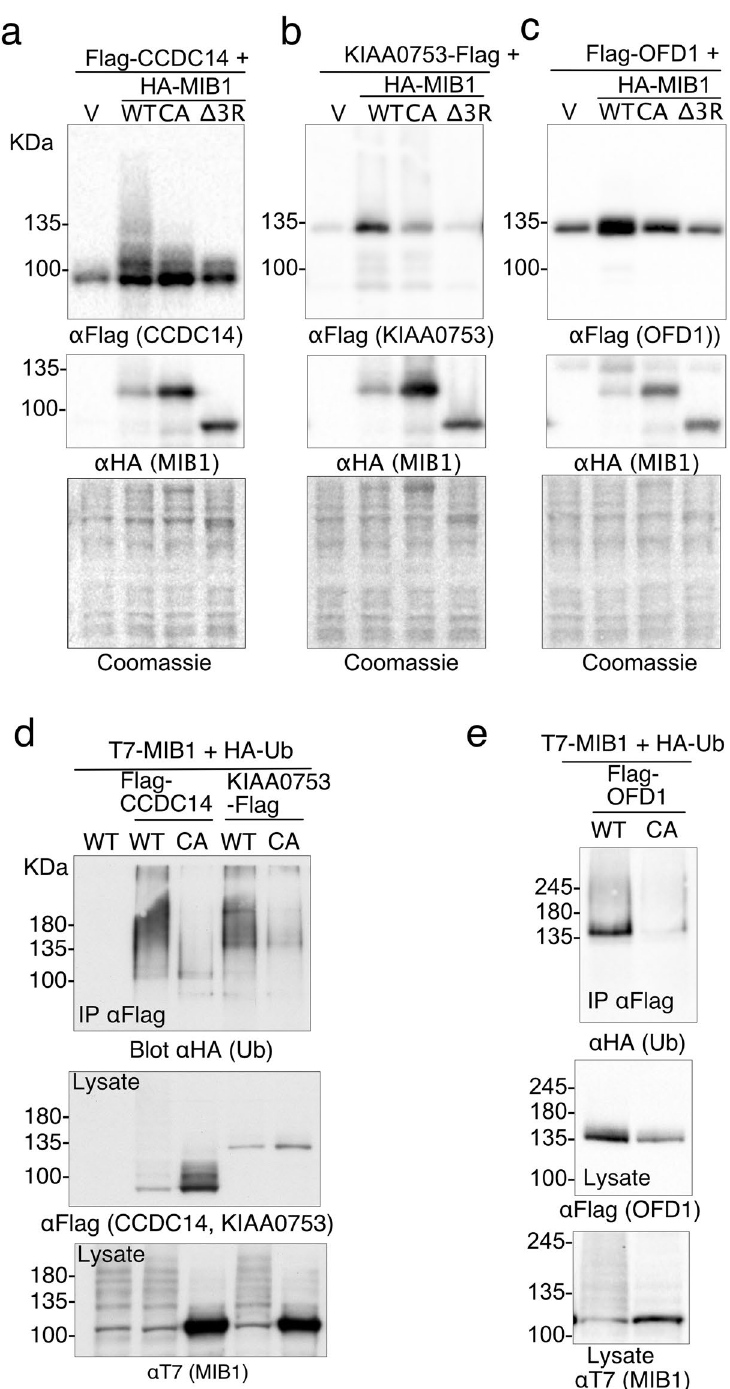
Figure 2. The centrosome-associated proteins CCDC14, KIAA0753 and OFD1 are ubiquitinated when co- expressed with MIB1. ( a – c ) Flag-CCDC14, KIAA0753-Flag or Flag-OFD1 were individually co-transfected into HEK293T cells with HA-MIB1 WT, a MIB1 mutant that disrupts the last RING finger domain (CA), or a MIB1 mutant that has the 3 RING domains deleted ( Δ 3R). After 18 hours, cell proteins were extracted in 1xLaemmli lysis buffer and boiled. Equal concentrations of protein were separated by SDS-PAGE and immunoblotted with either anti-FlagM2 or anti-HA (for MIB1). ( d , e ) Flag-tagged CCDC14, KIAA0753 and OFD1 were individually co-transfected with HA-Ub and either T7-MIB1 or T7-MIB1CA mutant. At 18 hours, cells were treated for 4 hours with 10 μ M MG132, followed by lysis is 1%SDS/RIPA lysis buffer and boiled. Flag-tagged proteins were immunoprecipitated from an equal concentration of cell lysate, and immunoblotted with anti-HA (Roche) to identify ubiquitinated proteins. Lysates (50 μ g) were immunoblotted for Flag-tagged substrate (middle panels) and T7-MIB1 (lower panels). Each figure is representative of at least 3 independent experiments. For clarity some blots were cropped. Full-length blots are shown in Fig.